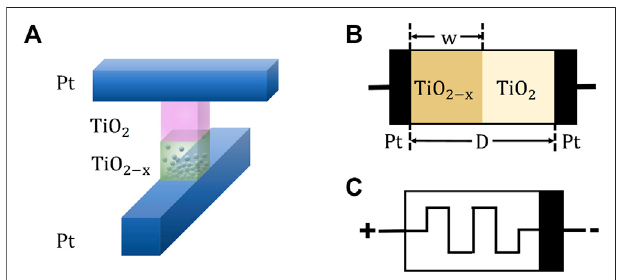
FIGURE 1 | (A) Schematic diagram of the implementation of the HP model in physics. (B) Sandwich structure comprising TiO 2 − x and TiO 2 layers and Pt. (C) Symbol of the memristor in